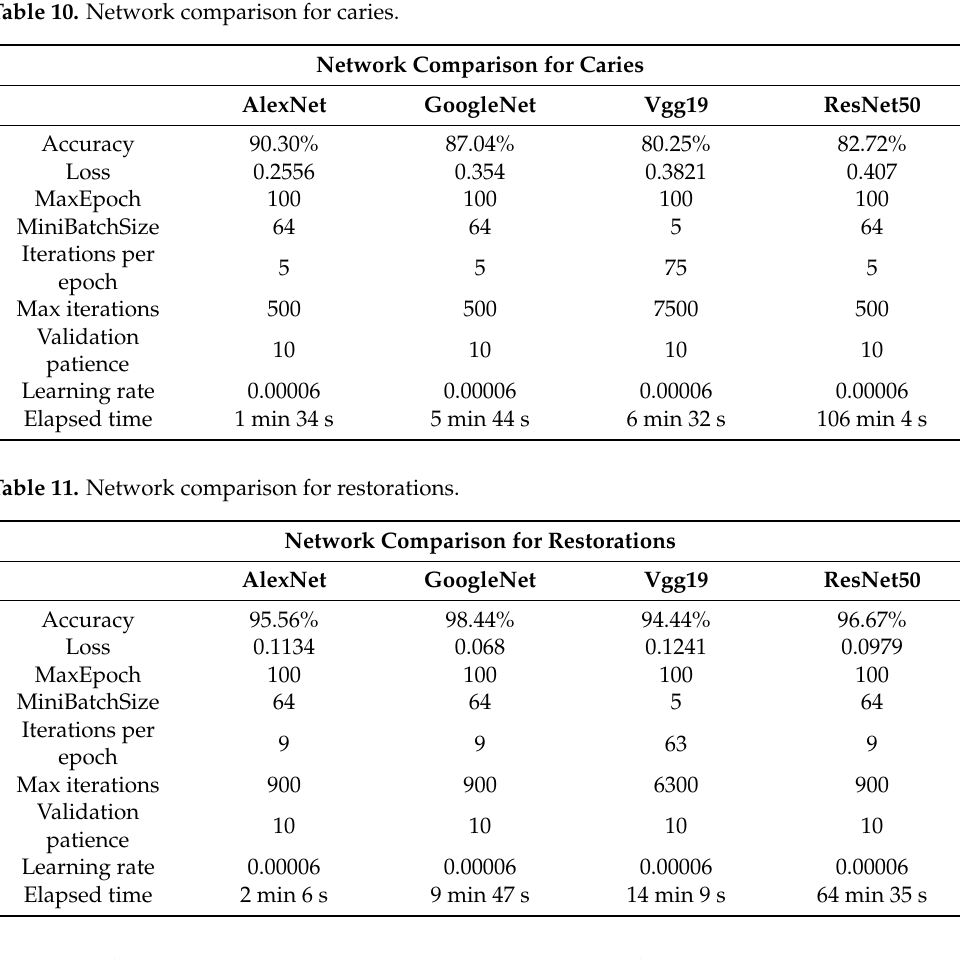
Figure 14. Loss process of the model in classifying restorations, with the black and orange lines illustrating the loss of the test set and training set, respectively.